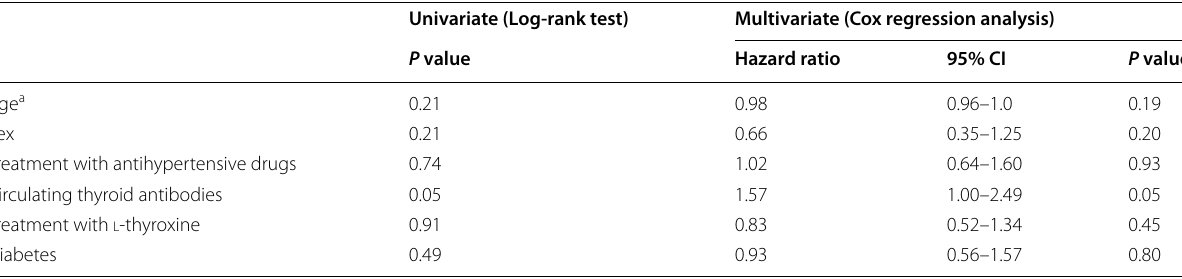
Table 5 Log-rank test and Cox regression analysis of the time taken to enter CKD3b